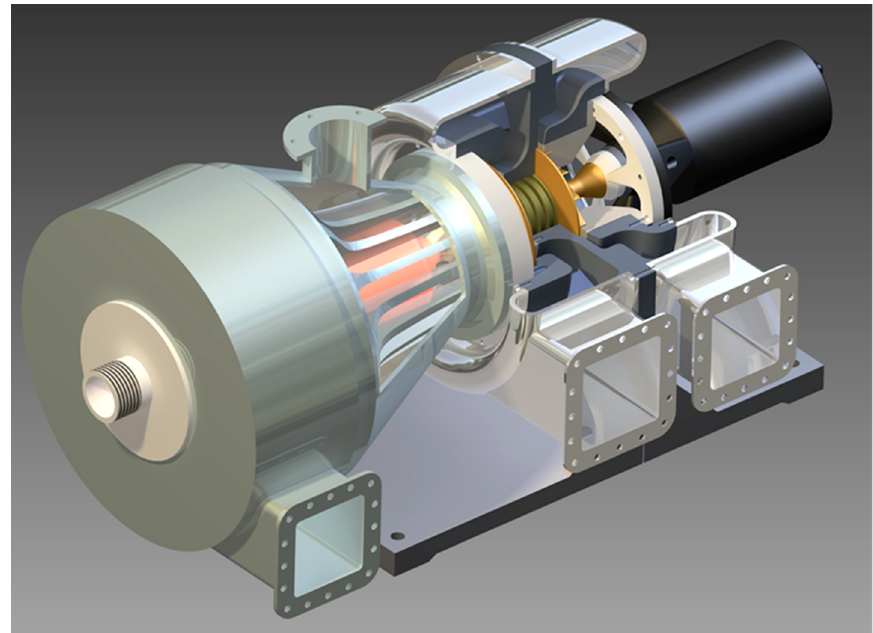
Figure 18. Example of an experimental variant of the innovative isothermal turbine.